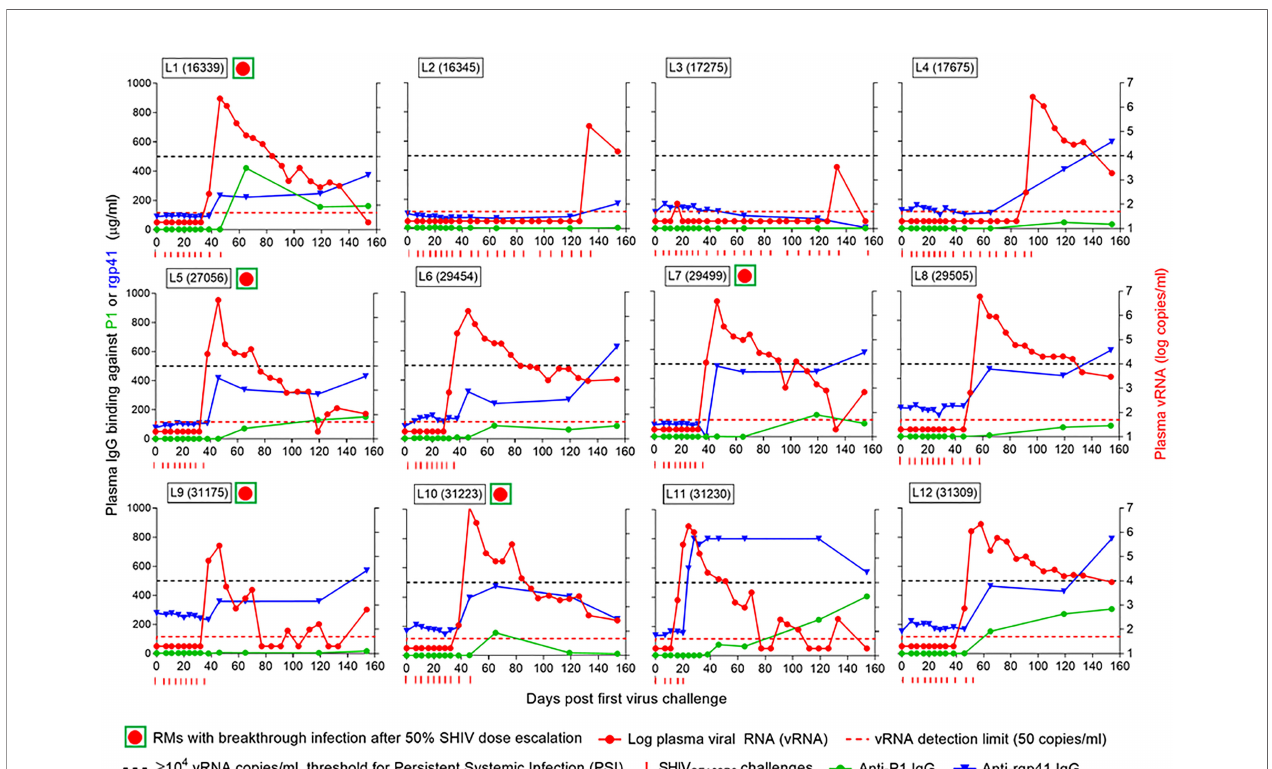
FIGURE 8 | Antigen-speci fi c IgG concentration in plasma samples and viral RNA (vRNA) loads over time. Each panel represents data for one rhesus macaque of Group L that had been vaccinated with the combination of virosome-P1 + virosome-rgp41. Red circles in green squares, RMs with breakthrough infection 6 days after increasing the SHIV challenge dose by 50% on day 32 (challenge #8; please see ). Red dotted line, limit of detection for vRNA [50 copies/ml (25)]. Black dotted line, ≥ 10 4 plasma vRNA copies/ml, threshold for Persistent Systemic Infection (PSI). Red ticks, time points at which each animal underwent SHIV SF162P3 challenges. Once vRNA levels were ≥ 10 4 copies/ml, no further virus challenges were administered. The number of SHIV SF162P3 challenges thus varied for each animal. Immediately following challenge #8 at the 50% higher virus dose, many Group L animals had breakthrough infections, which were not linked to decreases in anti-P1 or anti-rgp41 plasma IgG